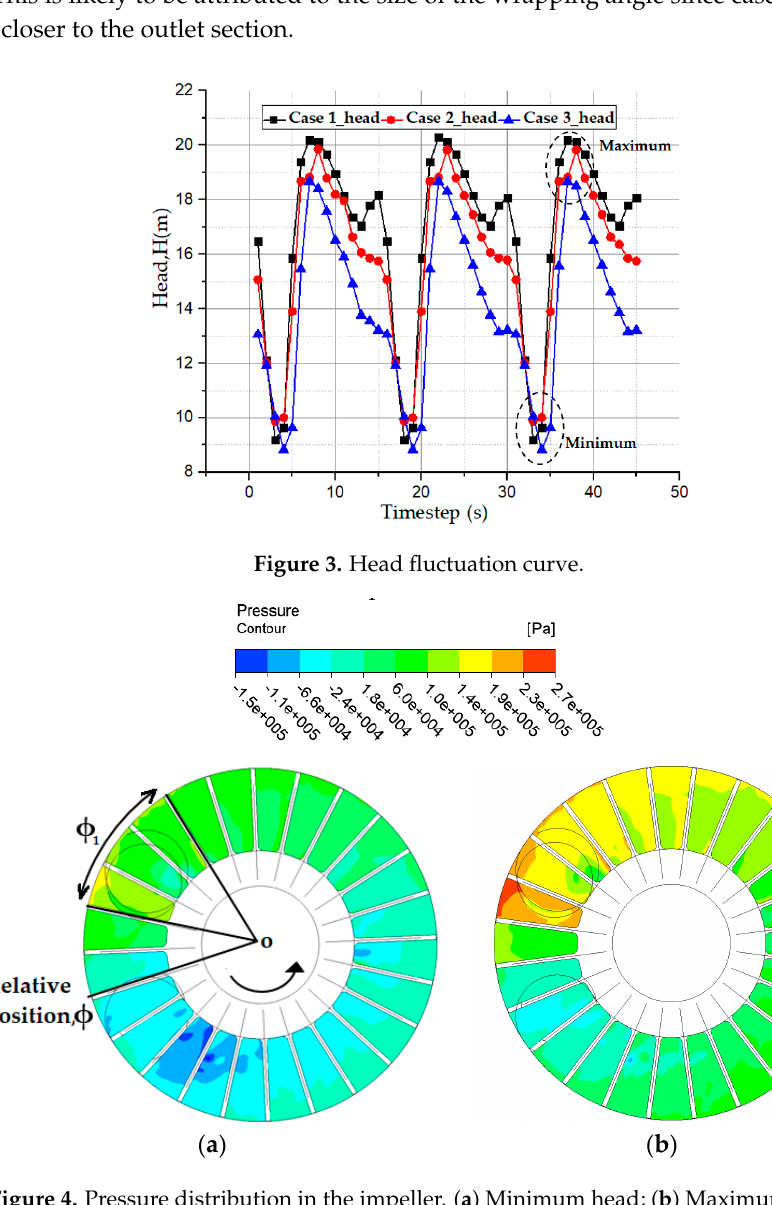
Figure 4. Pressure distribution in the impeller ( a ) Minimum head; ( b ) Maximum head.